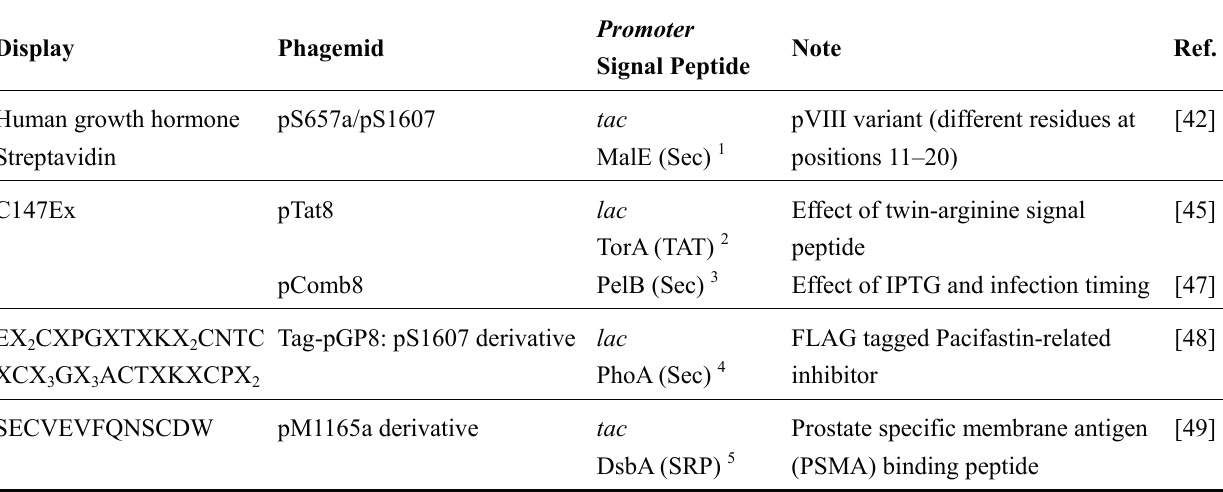
Table 1. Representative signal sequences used for pVIII-mediated phage